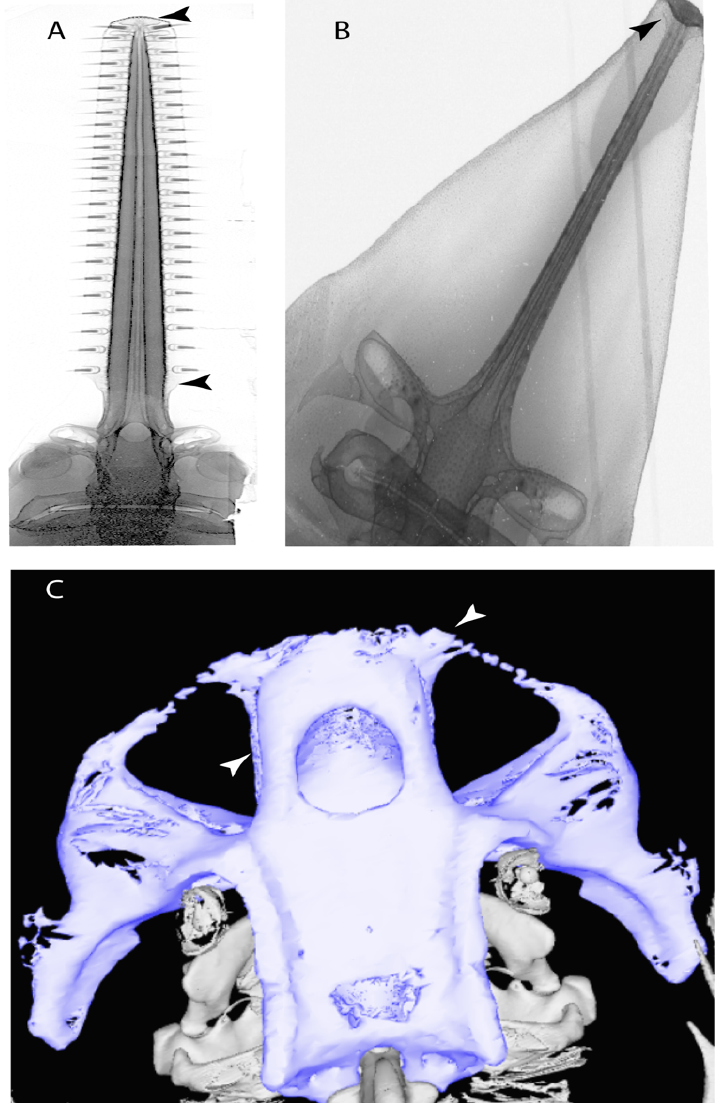
Figure 9. Rostrum of various Rhinopristiformes. State (1): ( A ) Pristis sp. (unpublished data); ( B ) Glaucostegus granulatus (NHMUK 2012.2.8.54); ( C ) Rhina ancylostoma (https://sharksrays.org/ (accessed on 23 March 2020)). Arrowheads indicate the rostral appendix at the base and tip or rostral